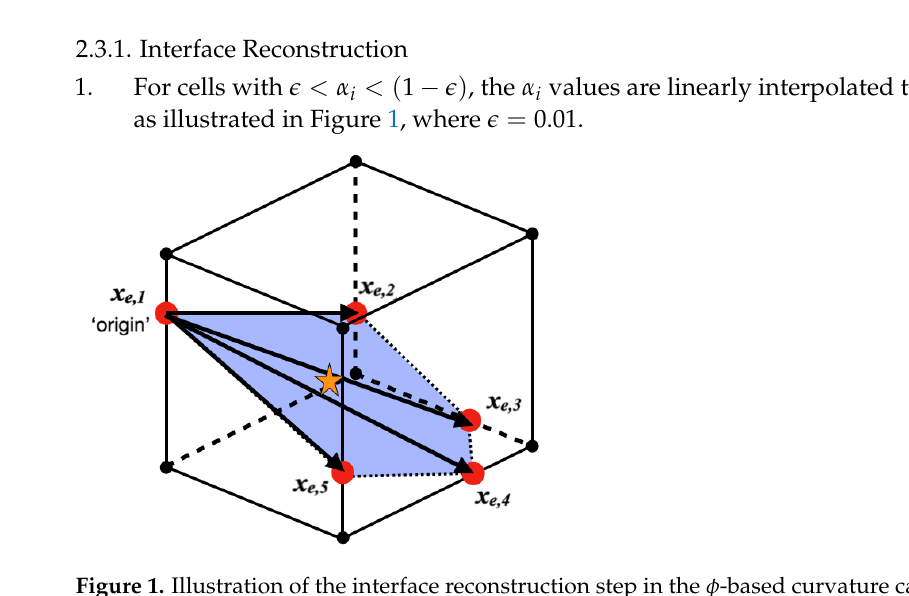
Figure 1. Illustration of the interface reconstruction step in the φ -based curvature calculation. Cell vertices are shown as black spheres and the polygon centroid is indicated by a star. Red spheres denote the location that corresponds to the interception of a cell edge with the local α = 0.5 isosurface. These locations are denoted as interface edge